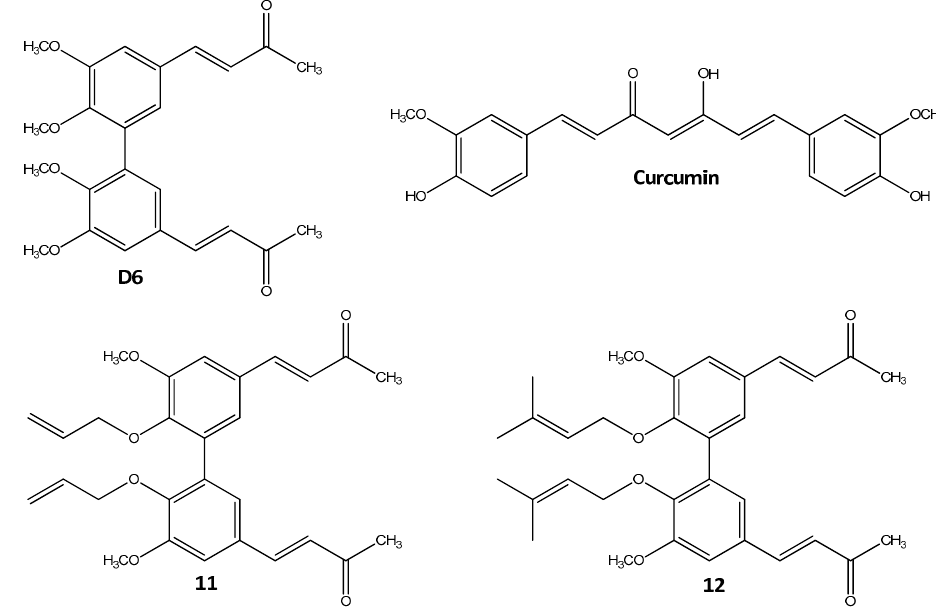
Figure 1. Chemical structures of 11 , 12 , D6, and